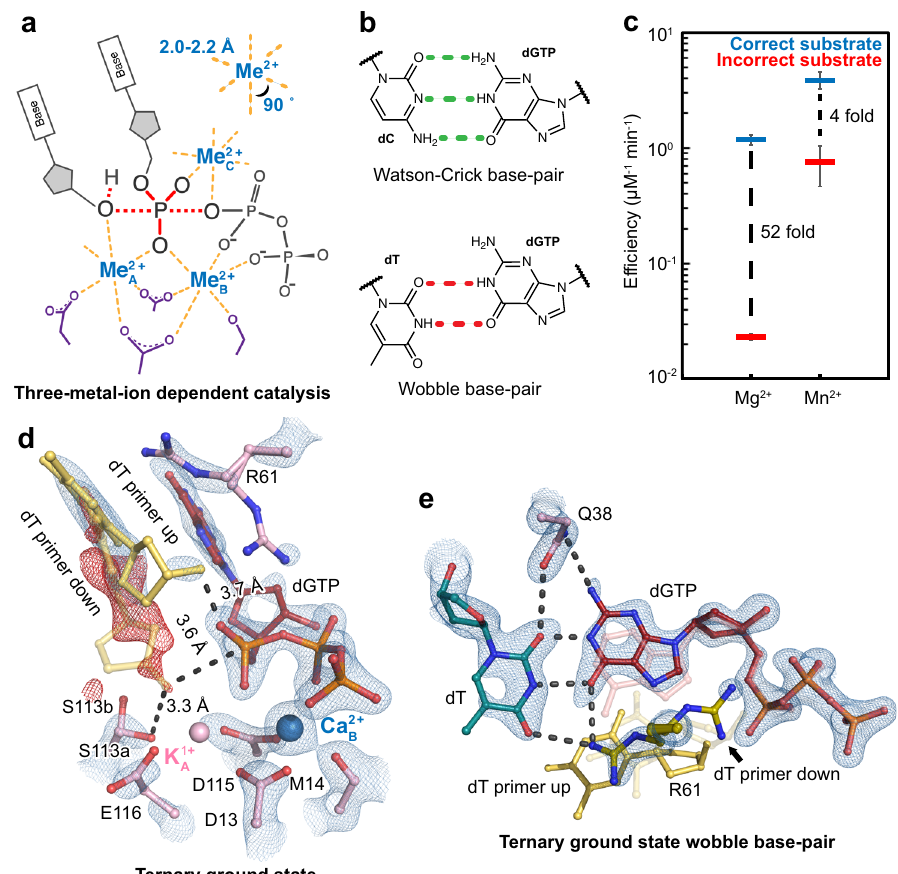
Fig. 1 Mechanisms of polymerase η catalysis and misincorporation. a Scheme of three-metal-ion dependent enzyme catalysis and transition state stabilization. Divalent metal ions optimally bind to their ligands with bond lengths of 2.0 – 2.2 Å at 90°. b Geometries of dGTP:dC Watson Crick base-pair and dGTP:dT wobble base-pair. c DNA polymerase fi delity in the presence of Mg 2 + versus Mn 2 + based on steady-state kinetics. The bars represent the mean of duplicate measurements for the catalytic ef fi ciencies (k cat /K M ) for incorporation of dATP (blue) and dGTP (red) opposite dT for Pol η with Mg 2 + and Mn 2 + (Supplementary Fig. 1). The errors bars represent the standard deviation for the measurements. The distance between the respective catalytic ef fi ciencies is a measure of discrimination. d Structure of Pol η ground state complexed with Ca 2 + . The 2F o -F c map for the primer up conformation, Me 2 + A , Me 2 + B , dGTP, and catalytic residues (blue) was contoured at 2 σ ( σ values represent r.m.s. density values). The F o -F c omit map for the down conformation of the primer (red) was contoured at 3 σ . e dGTP:dT wobble base-pairing (red and dark cyan), dATP (pink), and primer (yellow) in the Pol η ground state. The 2F o -F c map for dGTP, template dT, two conformations of R61, and Q38 (blue) was contoured at 1.8 σ